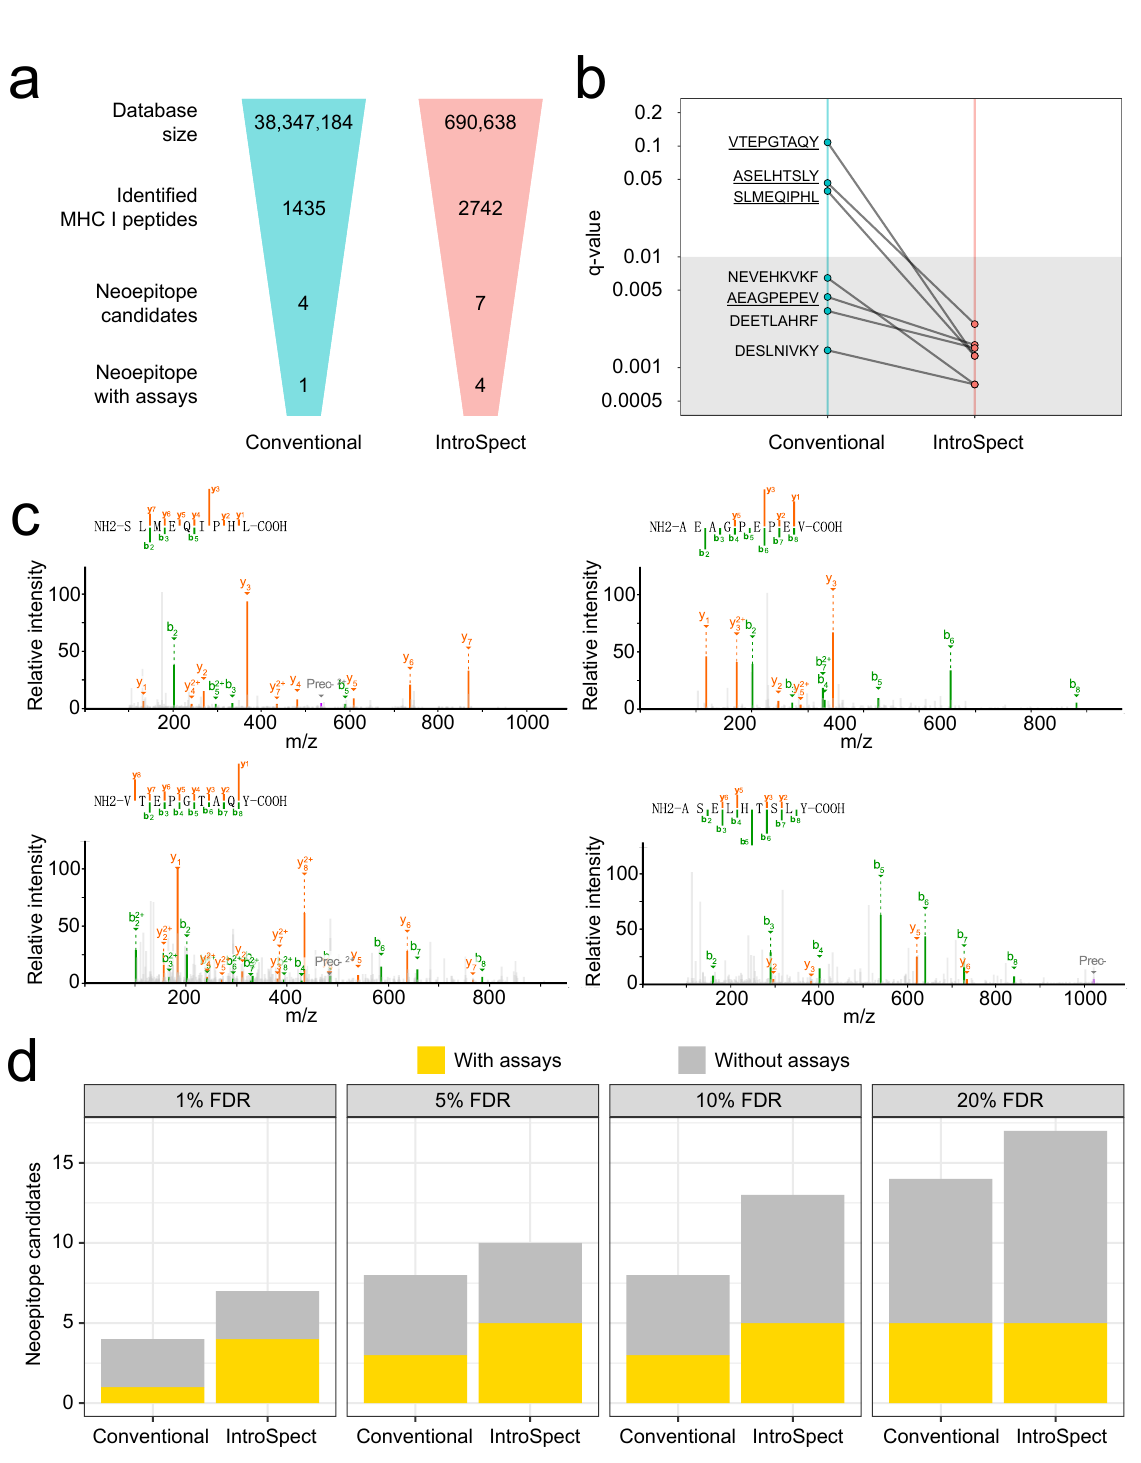
Figure 5. IntroSpect identified more neoepitopes than conventional search. ( a ) Flowcharts indicating key steps involved in neoepitope discovery. ( b ) Percolator q-values of neoepitopes identified by both methods are plotted. Underlined peptides have support in other studies. ( c ) Spectra of neoepitope candidates assigned by IntroSpect with assay support. Peaks represent b ions in green, y ions in orange and precursor ions in dark grey. ( d ) The numbers of neoepitopes identified by the two methods under different